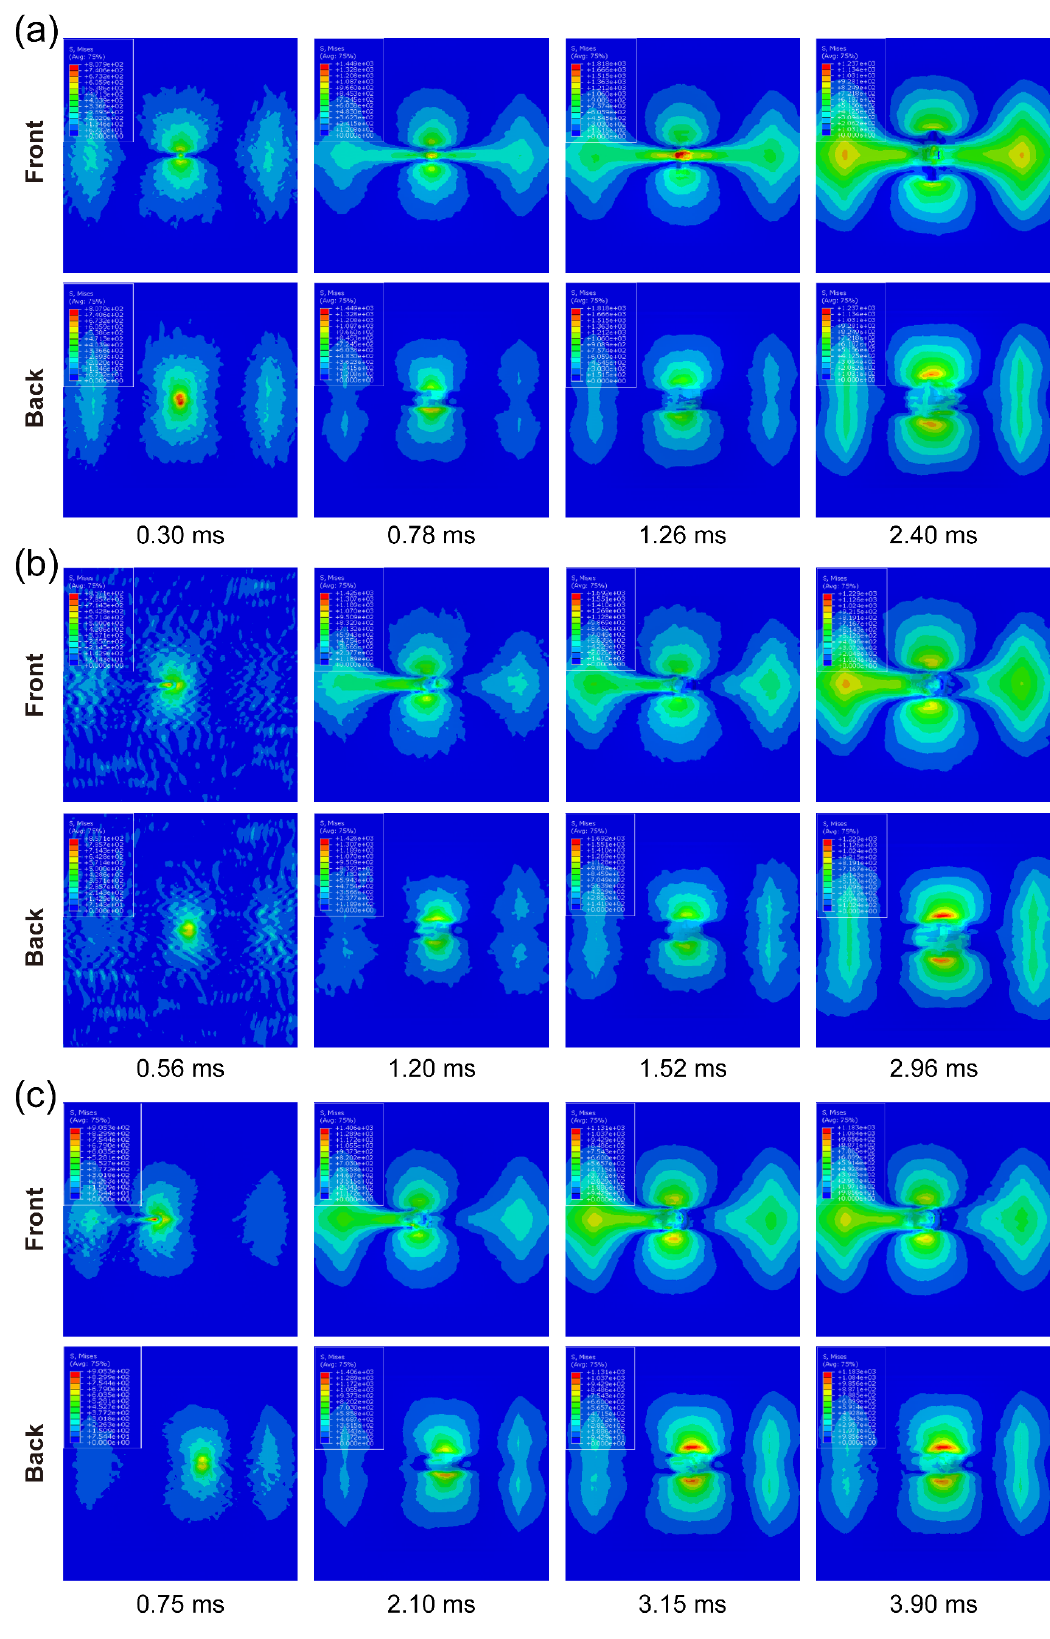
Figure 4. Progressive stress distribution on both sides of laminate with ( a ) 0 ◦ , ( b ) 30 ◦ , and ( c ) 60 ◦ impact angles under 20 J impact